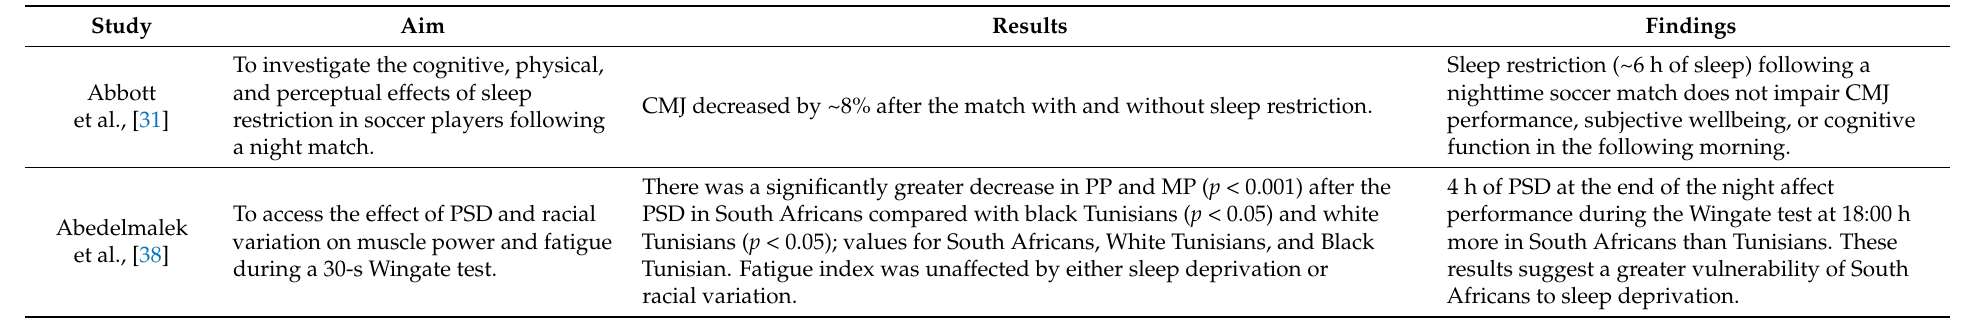
Table 4. Results concerning sleep and athletic and/or match